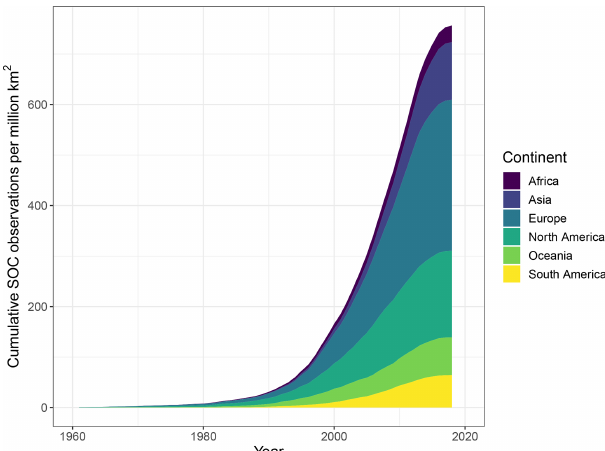
Figure 1. Number of published observations on soil organic carbon (SOC) changes driven by land management, land-use changes, and climate change (cumulative observations per million square kilome- ters) in each region. An observation indicates a set of measurements conducted in a site during a certain period. Data source: Beillouin et al.